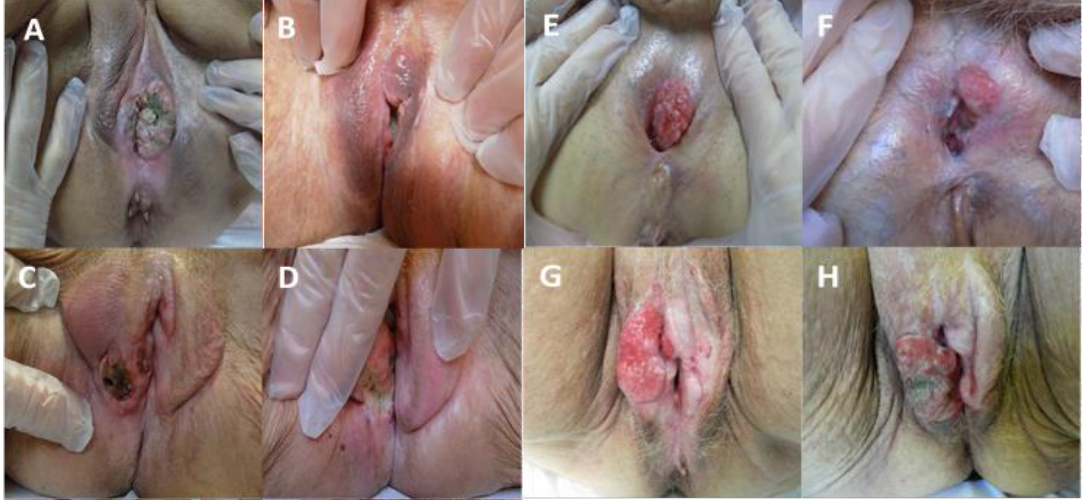
Figure 2. ( A , C , E , G ) nodules before Electrochemotherapy treatment; ( B , D , F , H ) nodules two months after ECT; ( B ) complete clinical response; ( D ) partial clinical response; ( F ) stable disease; and ( H ) progressive disease.